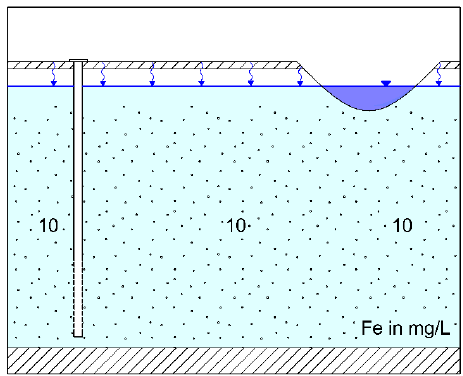
Figure 2. Case A – Low iron conc. in GW, increase due to RBF processes in riverbed and aquifer.